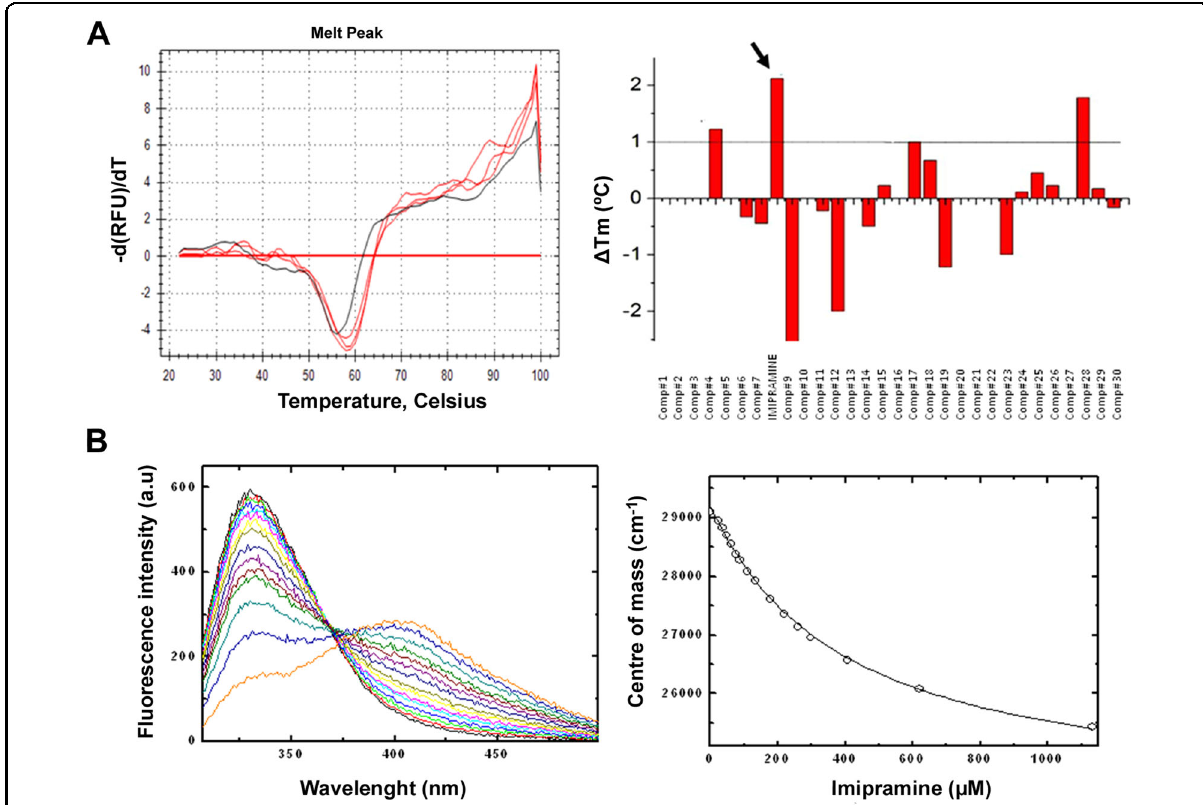
Fig. 2 In vitro validation of imipramine binding to fascin1. a Differential scanning fl uorimetry assays. The right panel shows the fi rst derivative of the thermal denaturation pro fi les of fascin1 in the absence (black) and in the presence of 1 mM imipramine (red in triplicate). The left panel summarizes the changes in T m induced by the presence of the selected compounds at 1 mM in 10% DMSO. b Fluorescence titration. The right panel shows the fl uorescence emission spectra of fascin1 in the presence of increasing concentrations of imipramine. The left panel shows the binding isotherm. White circles represent the center of mass of the different spectra, and the continuous lines symbolize the best fi t of the data to a one-site binding